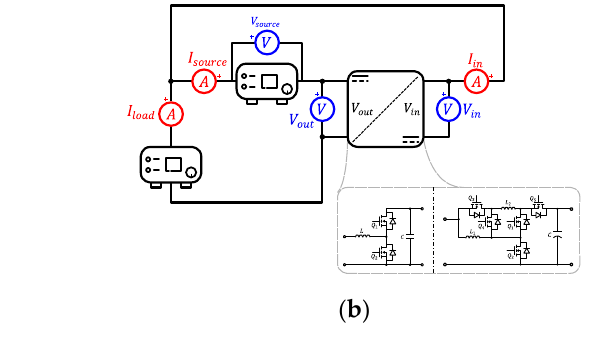
Figure 10. Experimental set-up. ( a ) FPC. ( b ) FC-type PPC.